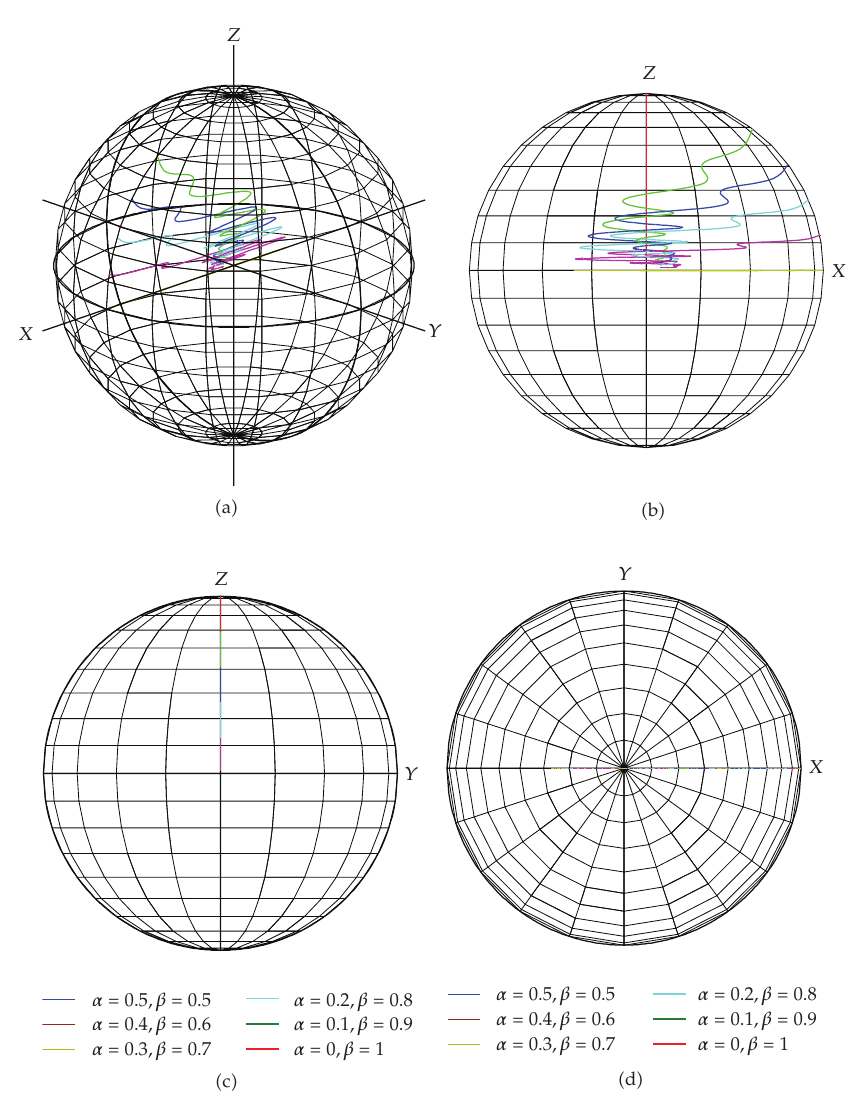
Figure 13: Excess electron spin dynamics on the bloch sphere for small Δ